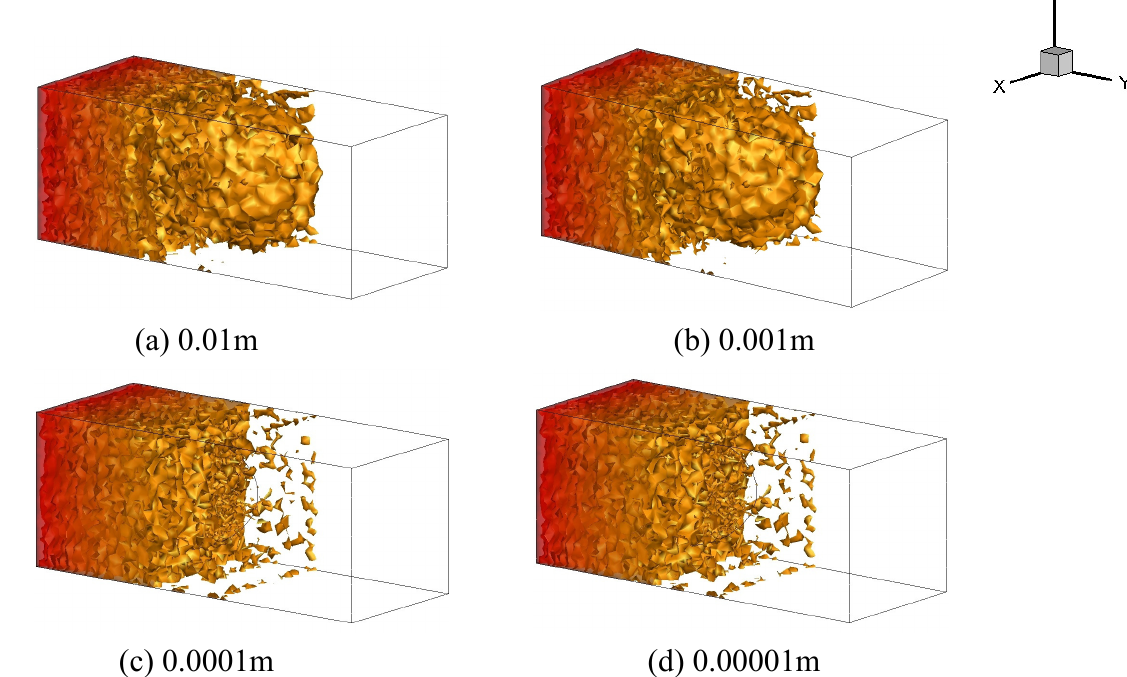
Figure 12. Grout penetration with a single fracture under different apertures in the porous medium considering the filtration